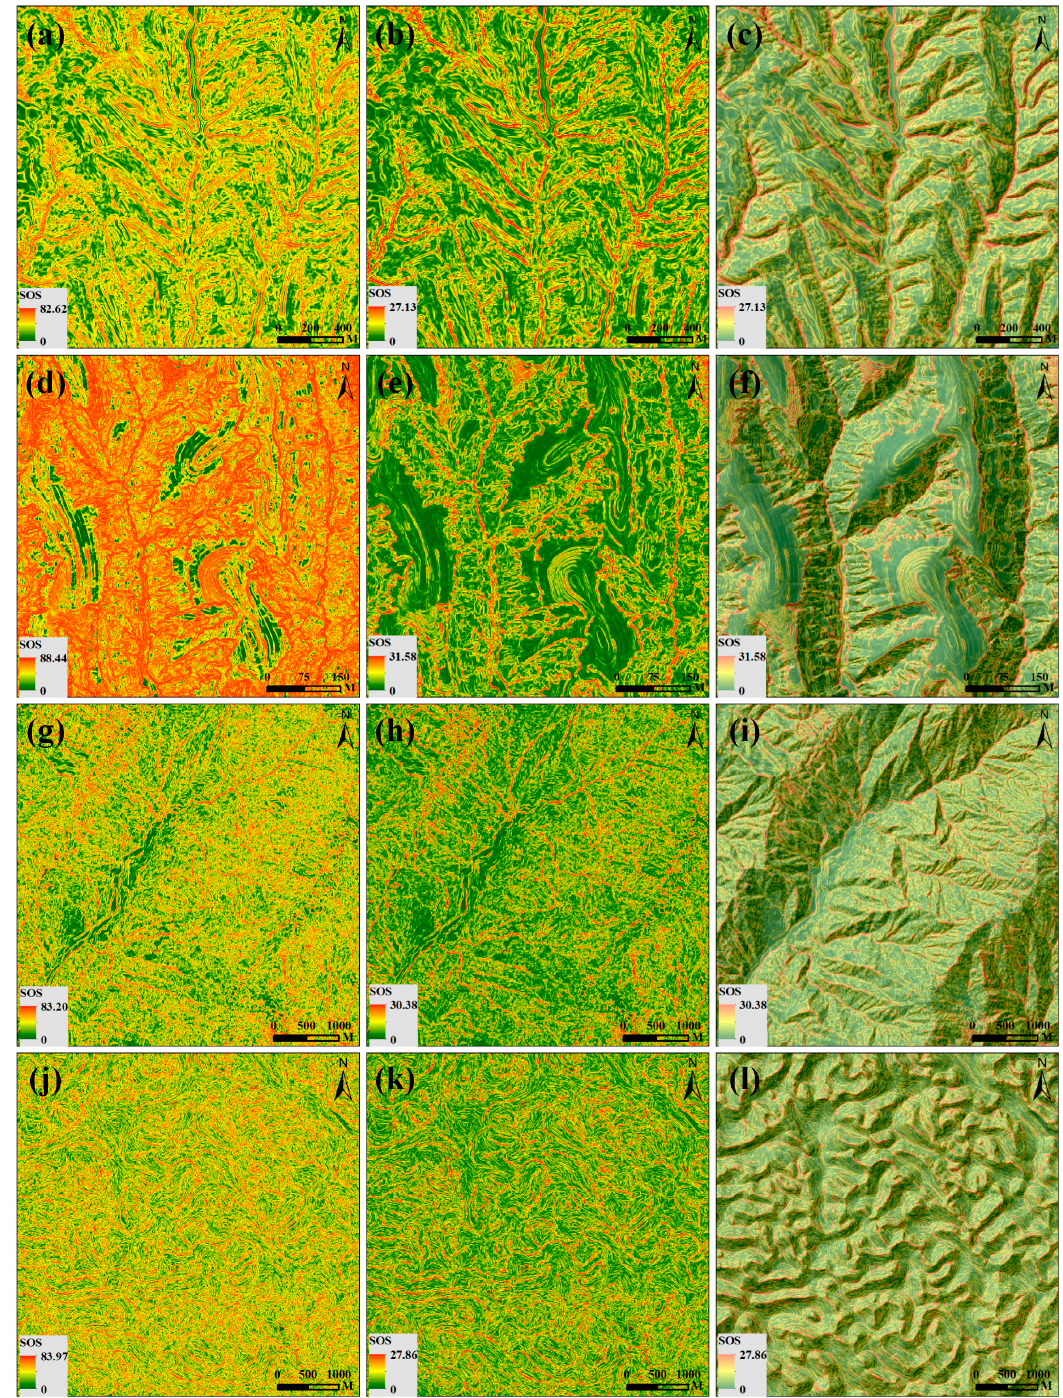
ff erent methods in di ff erent areas. ( a ) Direct and ( b ) vector methods in Suide 8 Figure 8. SoS results of di TA1, ( c ) vector method with hill shading in Suide TA1, ( d ) direct and ( e ) vector methods in Suide TA2, ( f ) vector method with hill shading in Suide TA2, ( g ) direct and ( h ) vector methods in Mount Lu, ( i ) vector method with hill shading in Mount Lu, ( j ) direct and ( k ) vector methods in Dahua, ( l ) vector method with hill shading in Dahua. The unit is